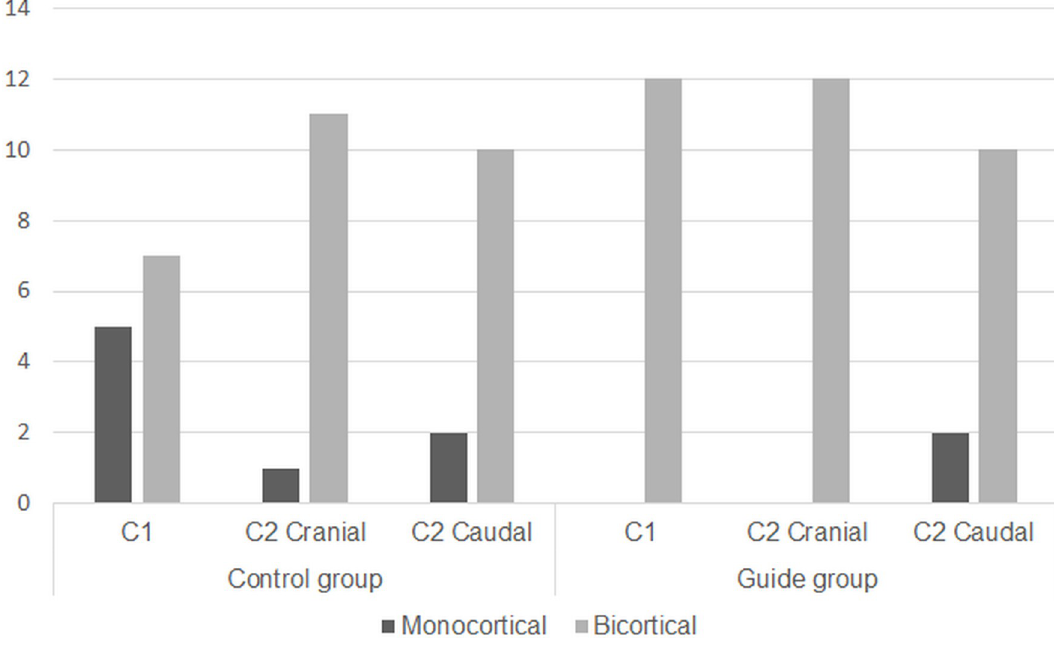
Fig 6. Evaluation of the bicortical screws.